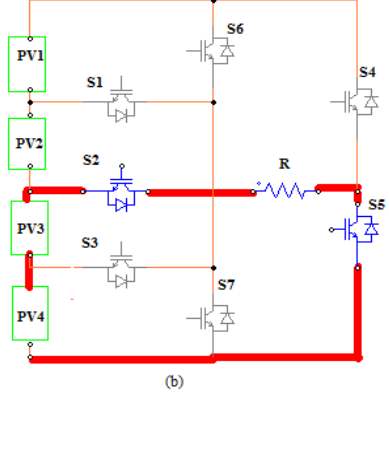
Table 1. Switching states and output voltages for the proposed inverter.